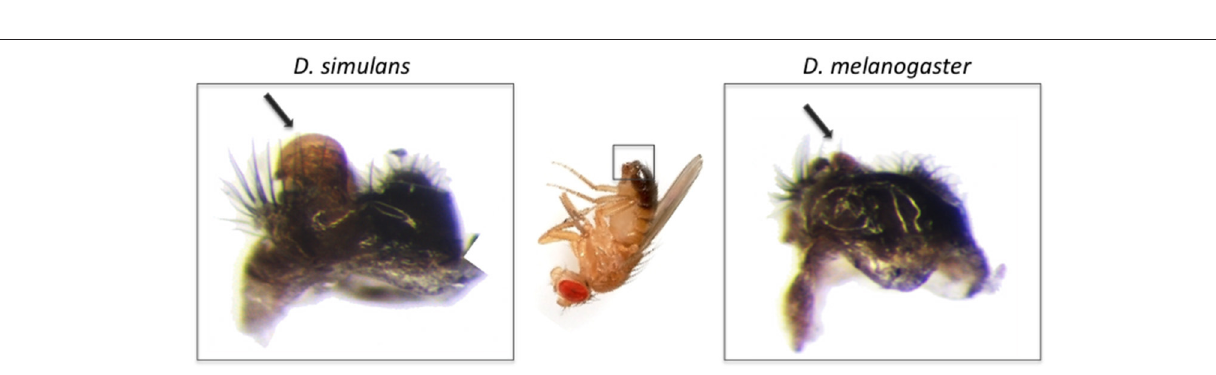
Frontiers in Ecology and Evolution |